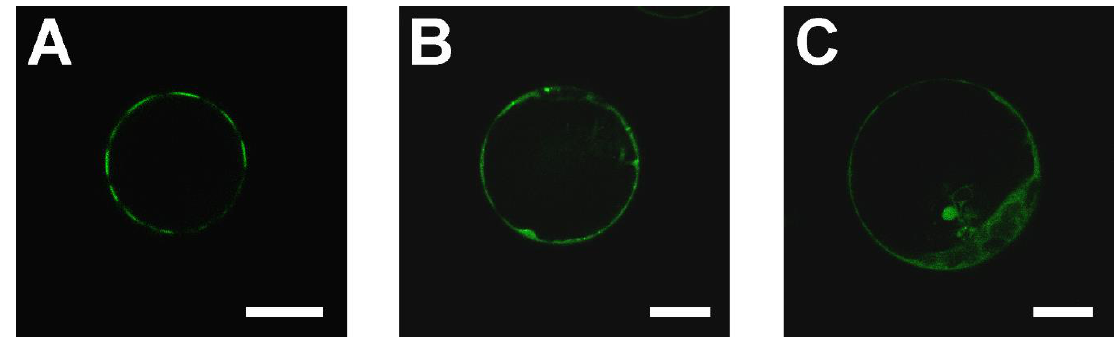
Figure 1. Analysis of the SAUL1 domain responsible for its function in patch formation. ( A ) GFP fluorescence of GFP- SAUL1ARM 7–11 following expression in mesophyll protoplasts, indicating patch formation. Patch formation was lost following the deletion of ARM repeats in GFP-SAUL1ARM 8–11 ( B ) and GFP-SAUL1ARM 7–10 ( C ). Scale bars represent 15 µm.